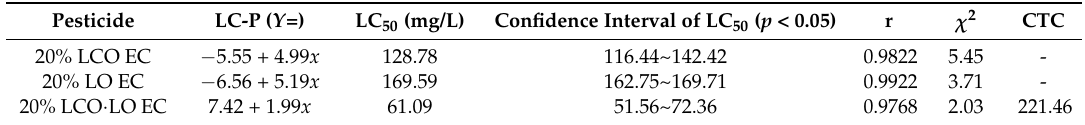
Table 5. Co-toxicity coefficient (CTC) value of 20% LCO · LO EC to Aphis citricola van der Goot. Pesticide LC-P ( Y =) LC 50 (mg/L) Confidence Interval of LC 50 ( p < 0.05)